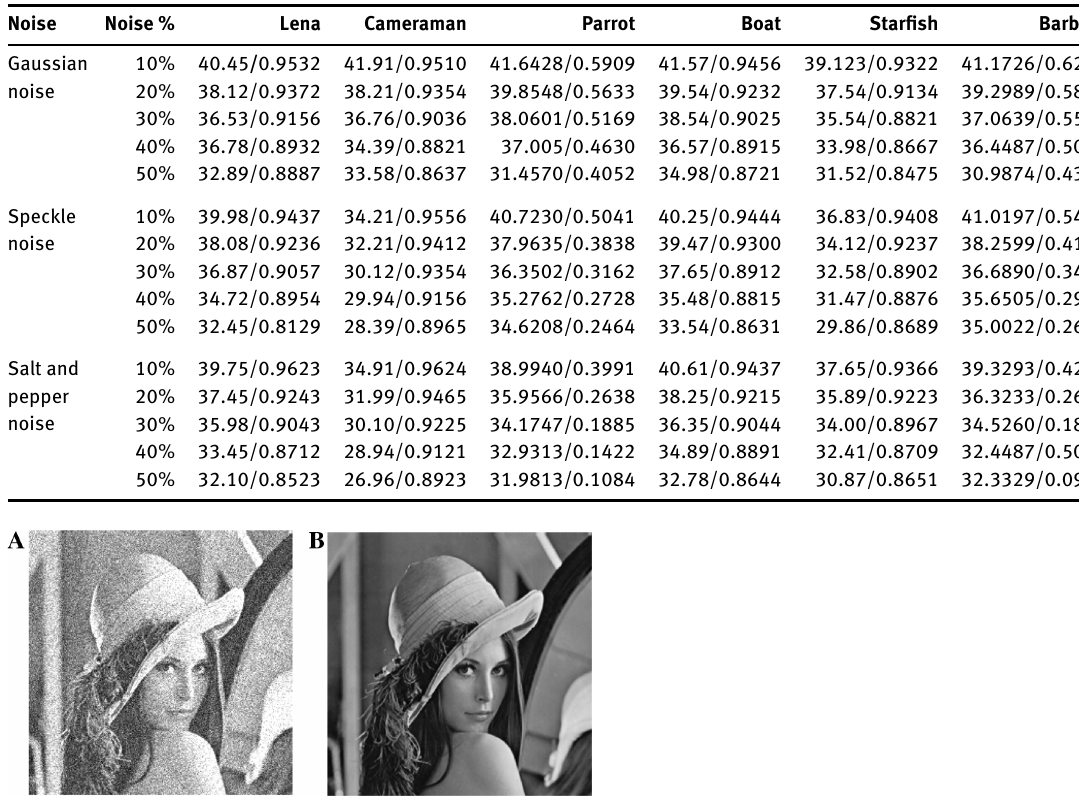
Table 3: Performance Analysis of the LR-SVM-HLOG Method (Right Side Is PSNR and Left Side Is SSIM).